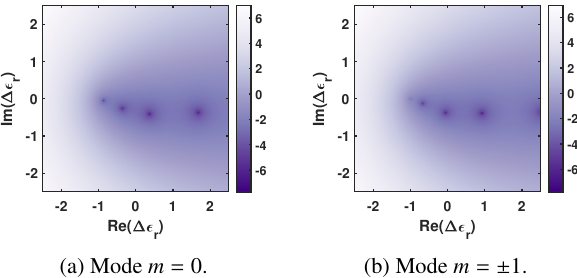
Figure 3: Determinant for a cylinder with radius 400 nm at λ = 400 nm plotted in the complex plane of ∆ ε r (logarithm of absolute